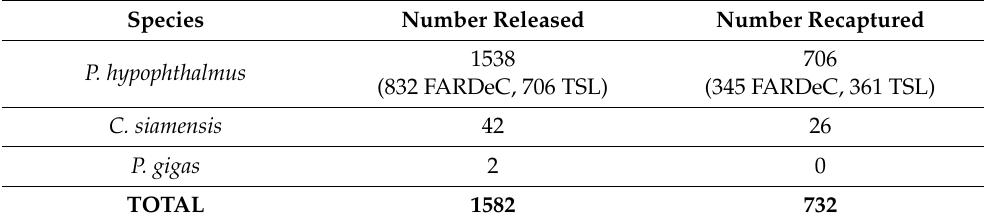
Table 2. Summary of the numbers of fish released and recaptured. TSL indicates Tonle Sap Lake. Species